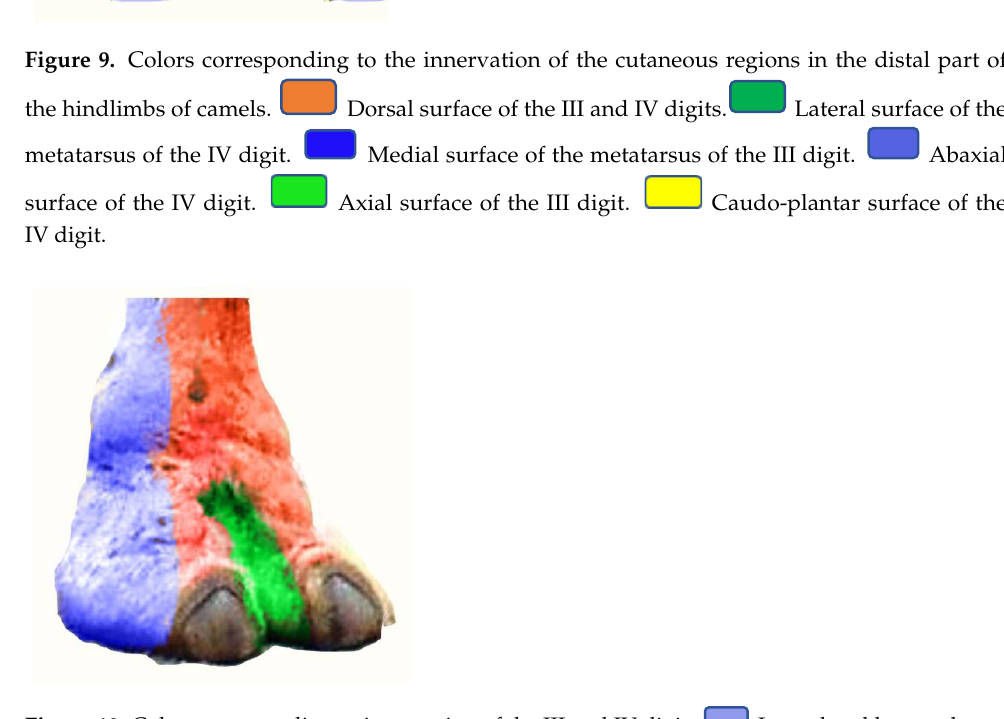
Lateral and latero-plantar Dorsal aspect Dorsal aspect Medial and medio-plantar Medial and